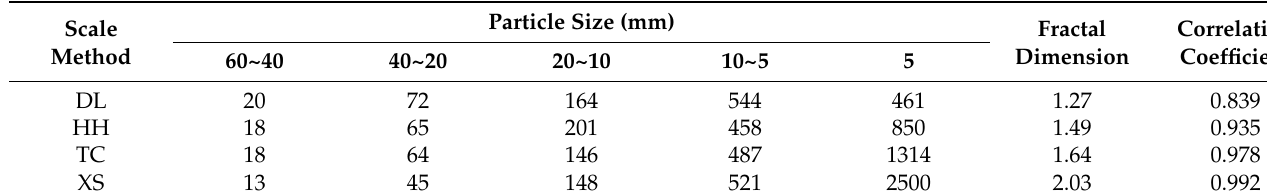
Table 1. The number of particles for numerical samples and test results. Table 1. the number of particles for numerical samples and test results.